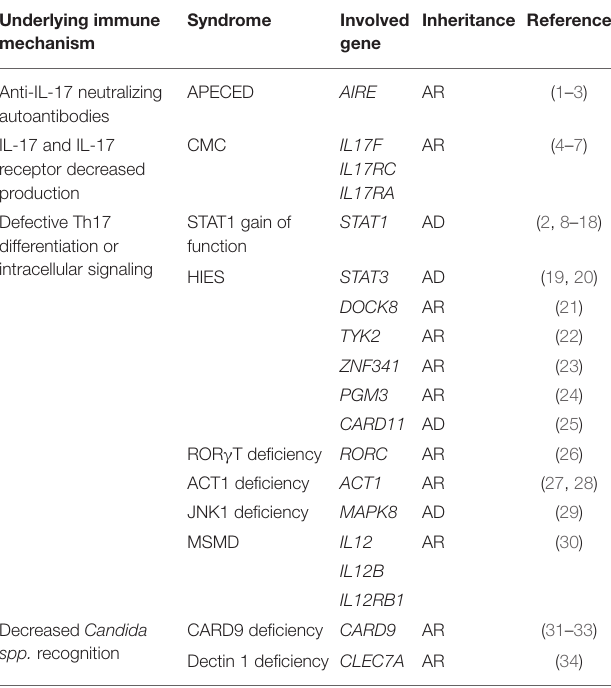
TABLE 1 | Reported genes associated with chronic mucocutaneous